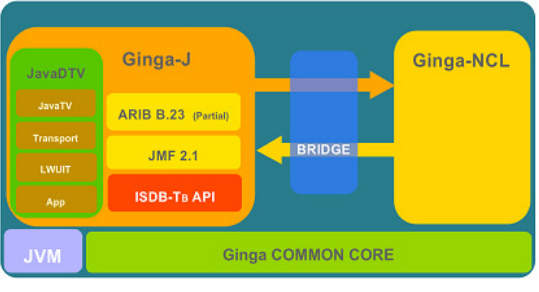
Figure 2. Ginga-J